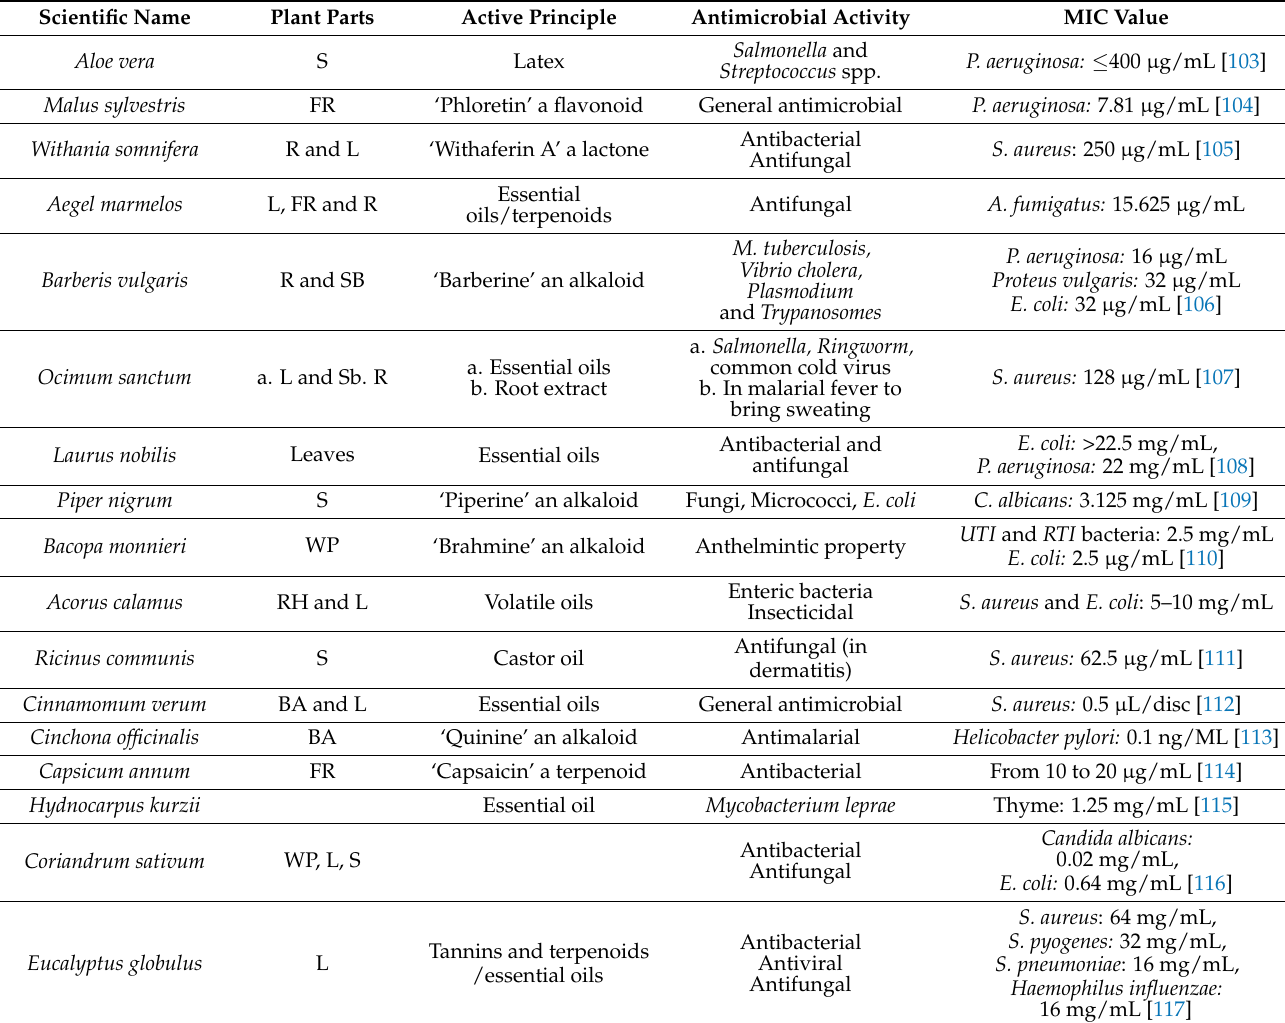
Table 1. Plants with antimicrobial characteristics have been utilized in traditional medicine mL